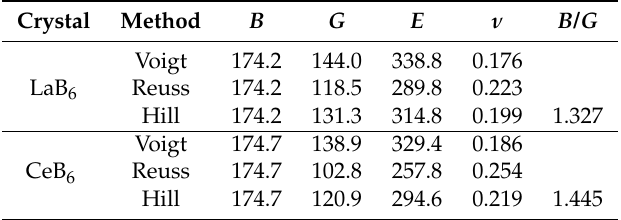
Table 5. Polycrystalline bulk modulus B , shear modulus G , and Young’s modulus E (in GPa), and Poisson’s ratio ν of LaB 6 and CeB 6